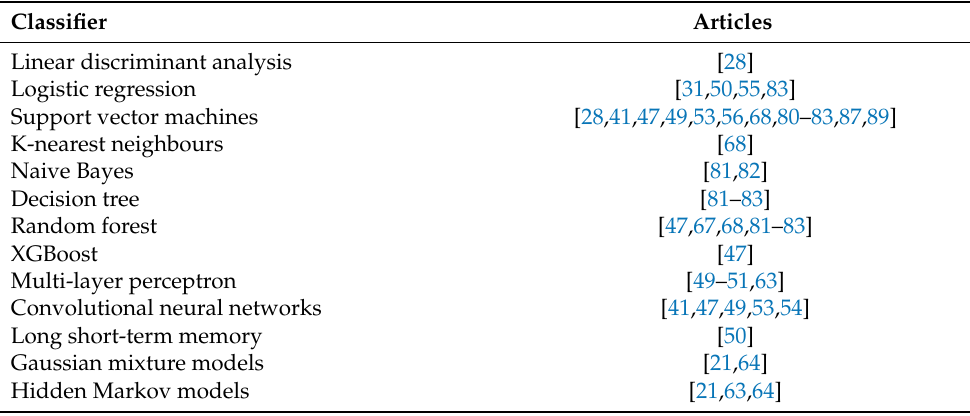
Table 7. Classification algorithms.